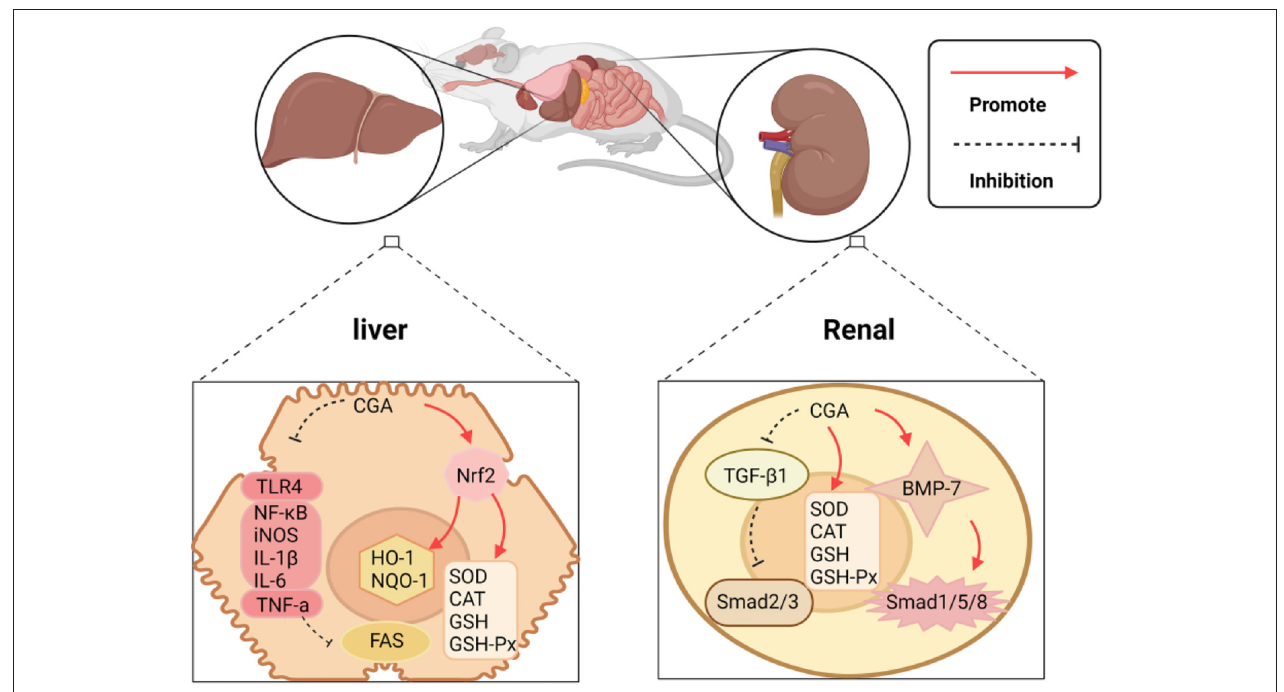
FIGURE 5 | CGA protects the liver and kidney